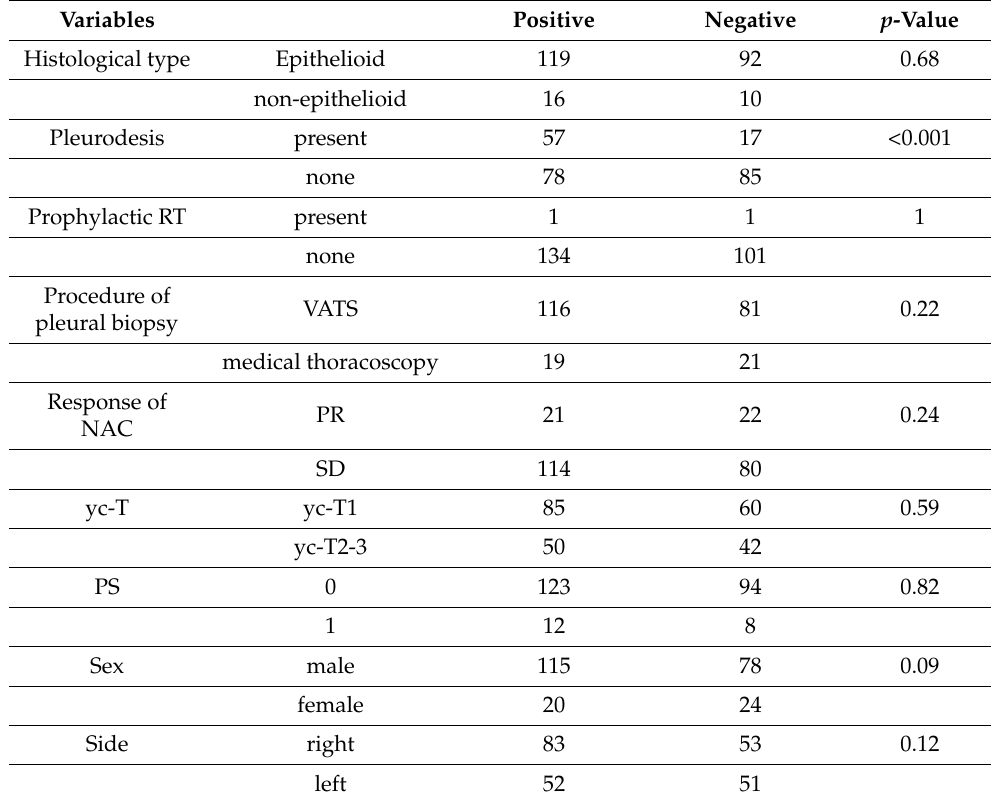
Table 3. Univariate analyses between p-CWM and clinical variables.